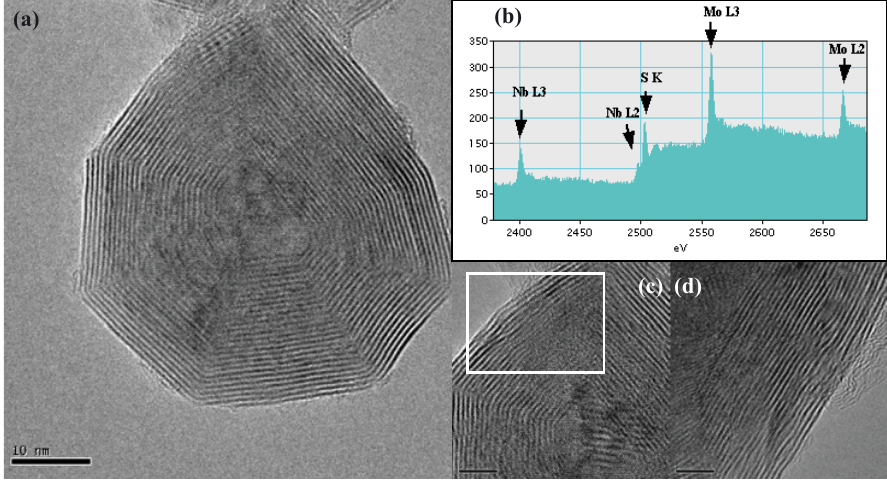
Figure 13. (a) HRTEM image and (b) the corresponding EELS spectrum of the IF-Mo nanoparticle in (a) showing mismatch in the layers, (d) HRTEM of another IF nanoparticle showing defects/dislocations in the layers (adapted from Ref. 55).